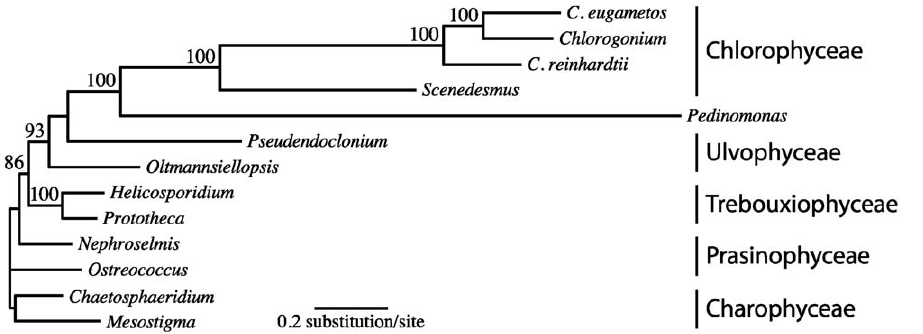
Figure 4. Phylogenetic position of Helicosporidium sp. ATCC 50920 as inferred from amino acid sequences derived from the seven protein-encoding genes that are shared between all sequenced chlorophyte mtDNAs. The best ML-tree inferred with PHYML 3.0 under the LG + C 4 + F + I model of amino acid substitutions is shown here (13 taxa, 2362 positions, 1373 phylogenetically informative). The charophyte green algae Mesostigma viride and Chaetosphaeridium globosum were used as outgroups. Bootstrap values over 80% are shown above the corresponding nodes. Branch lenghts are drawn to scale. Pedinomonas minor has not yet been assigned unambiguously to one the four classes of chlorophyte green algae.